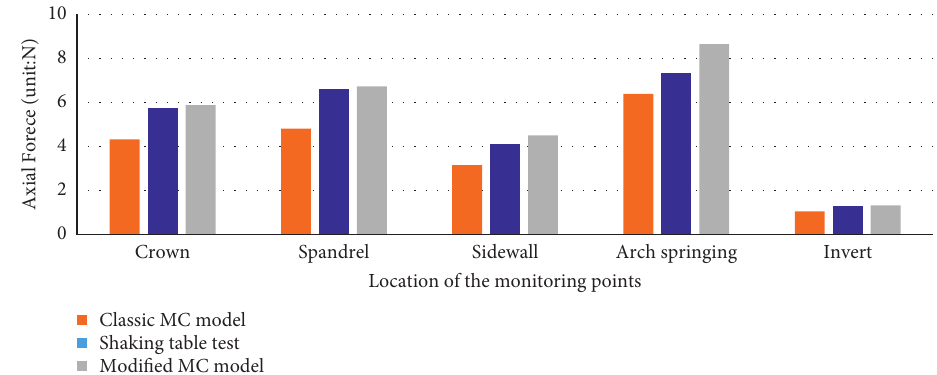
Figure 29: Histogram of the maximum axial forces at section 2 for the different yield criterion